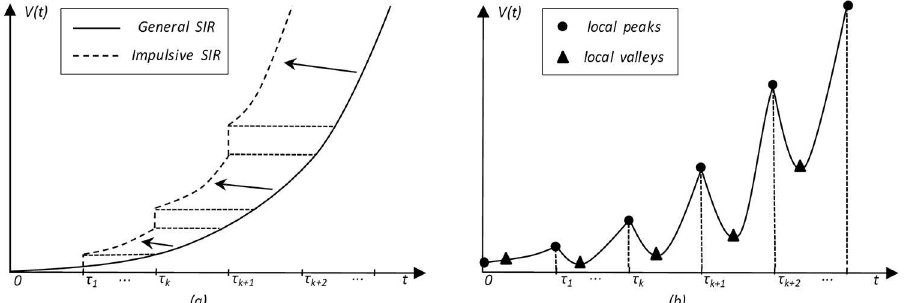
Fig 1. Comparison of the theoretical impulsive SIR diffusion curve and the actual online on-demand streaming curve. (a) The J-shaped solid curve indicates the generalSIR diffusion process within the initial limited duration, while the piecewisebroken curve indicates the step increment effect of impulsive stimulation at every update time τ k . (b) The actual online on-demand streaming curve is a zigzag. Possible explanations are as follows: faithful fans who seek new episodesform the local sharp peaks at every update time τ k (marked by small round circles); feverish audiencesrapidly decrease to form the subsequent valley (marked by small triangles); promotion and buzz cause the slow climb before the next update time τ k +1